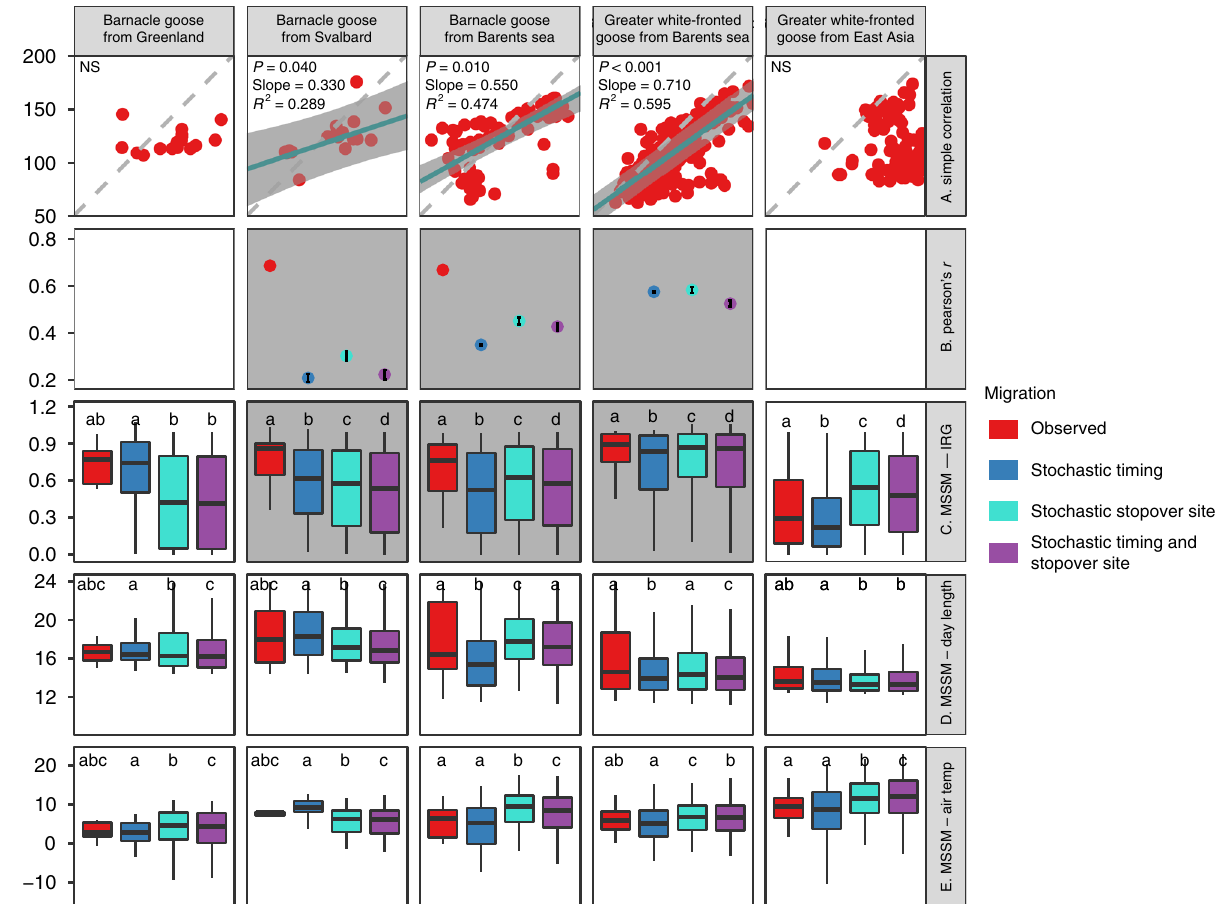
Fig. 2 Testing the green wave hypothesis for grazers by three different methods. We present the results of the Simple Conventional Correlation (a, upper row), Correlation method evaluated by stochastic migrations (b, second row) and the Metric Selection approach based on Stochastic Migrations (MSSMs) (c – e, three lower rows). Red, blue, turquoise and purple dots/boxes denote observed, stochastic timing, stochastic stopover site and stochastic timing and stopover site migrations, respectively. a The x and y axes denote the expected arrival day of the year at stopover sites (the day with peak instantaneous rate of green-up [IRG] value) and the observed arrival day of the year by birds, respectively. The grey pecked lines with slope = 1 and intercept = 0 indicate perfect match of migration and green wave. N.S. denotes insigni fi cant slope; otherwise the p- value and coef fi cient of the slope, and marginal R 2 are provided. Blue lines show the signi fi cant positive slope of the green wave in models of green wave surfers, and grey bands are the prediction intervals of the models. b Pearson ’ s correlation coef fi cient r and 95% CI ( y axis) of observed and stochastic migrations ( x axis). For populations without available migration tracks, only stochastic timing simulations were performed, compared and plotted. Blank panels denote not applicable because this method only applies to green wave surfers or weak surfers identi fi ed by Simple Conventional Correlation. c – e Three metrics compared for observed versus stochastic migrations: IRG (instantaneous rate of green-up), day length and air temperature. Lower case letters indicate signi fi cantly different groups using Kruskal – Wallis test followed by Dunn ’ s test of multiple comparisons. Boxplots show median, fi rst and third quartiles with whiskers reaching to the last data point within 1.5 × interquartile range. For clear presentation, outliers out of 10 and 90% quantiles were excluded from the plots but kept in all analyses. All grey shaded plots in all panels denote signi fi cant migration – green wave associations. Source data are provided as a Source Data fi